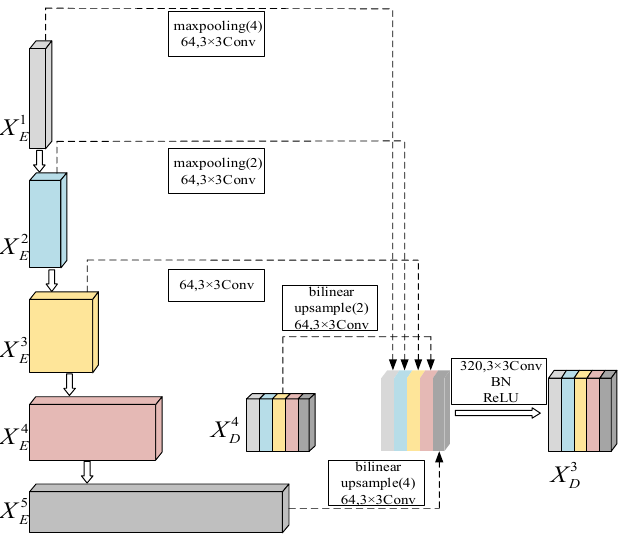
Figure 1. The network architecture of U-net3+.